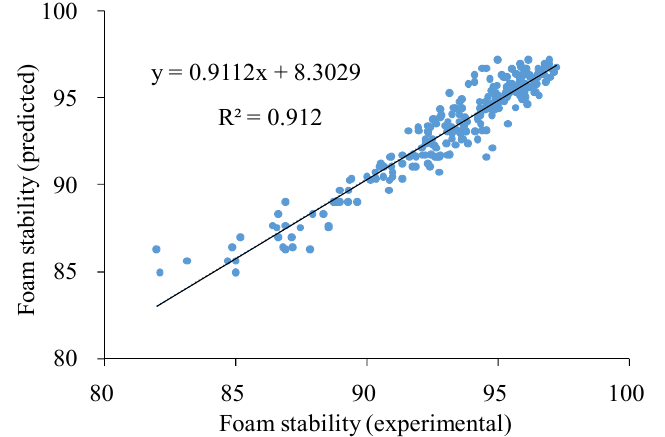
y = 0.9112x + 8.3029